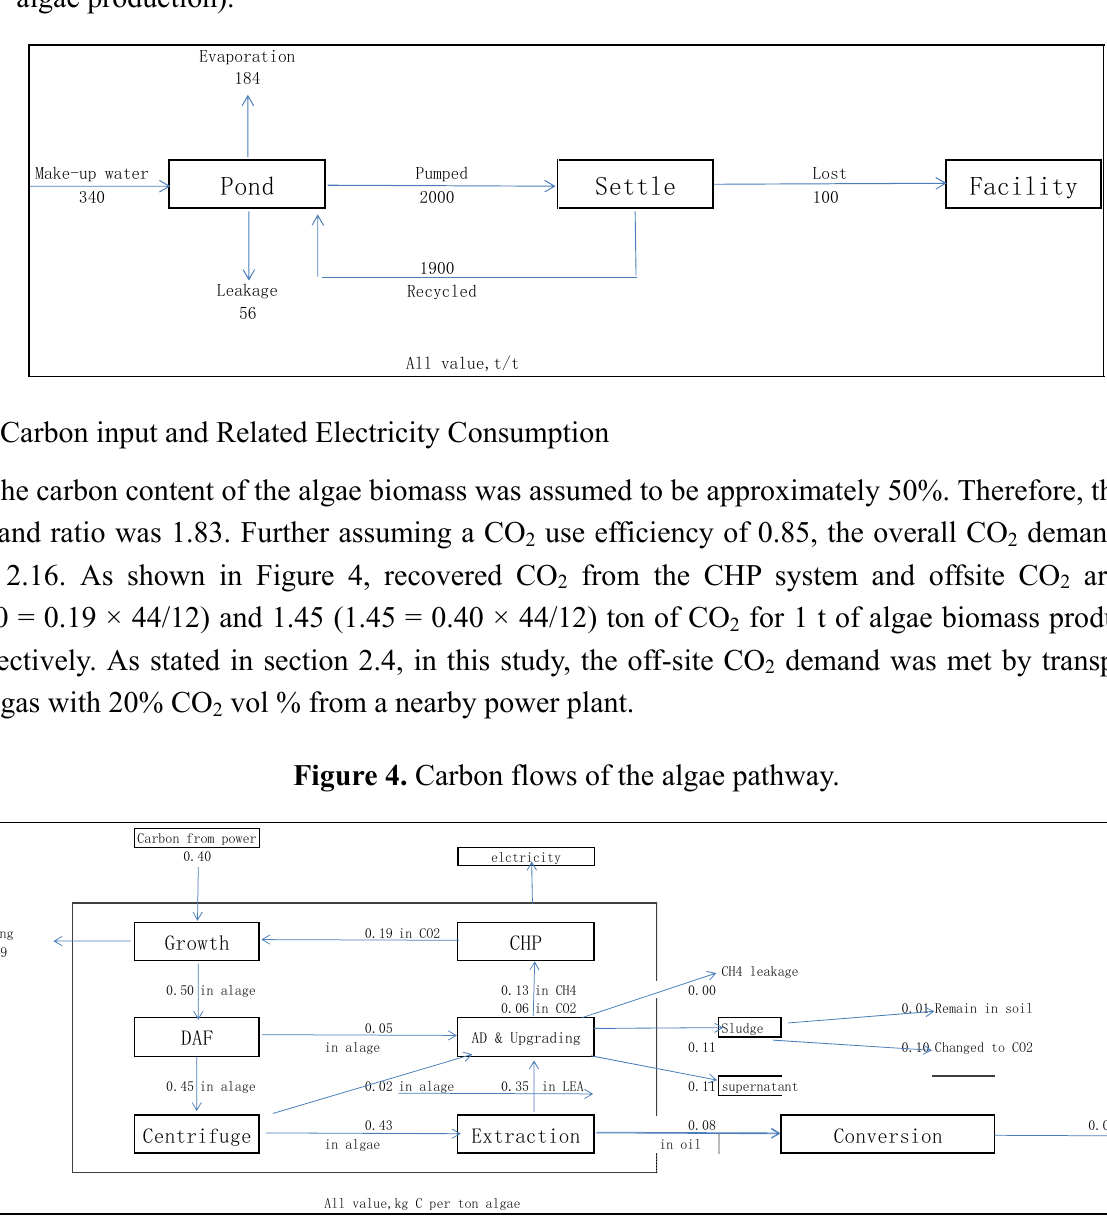
Figure 3. Water balance during algae growth and harvesting (ton of water per dry-ton of algae production).